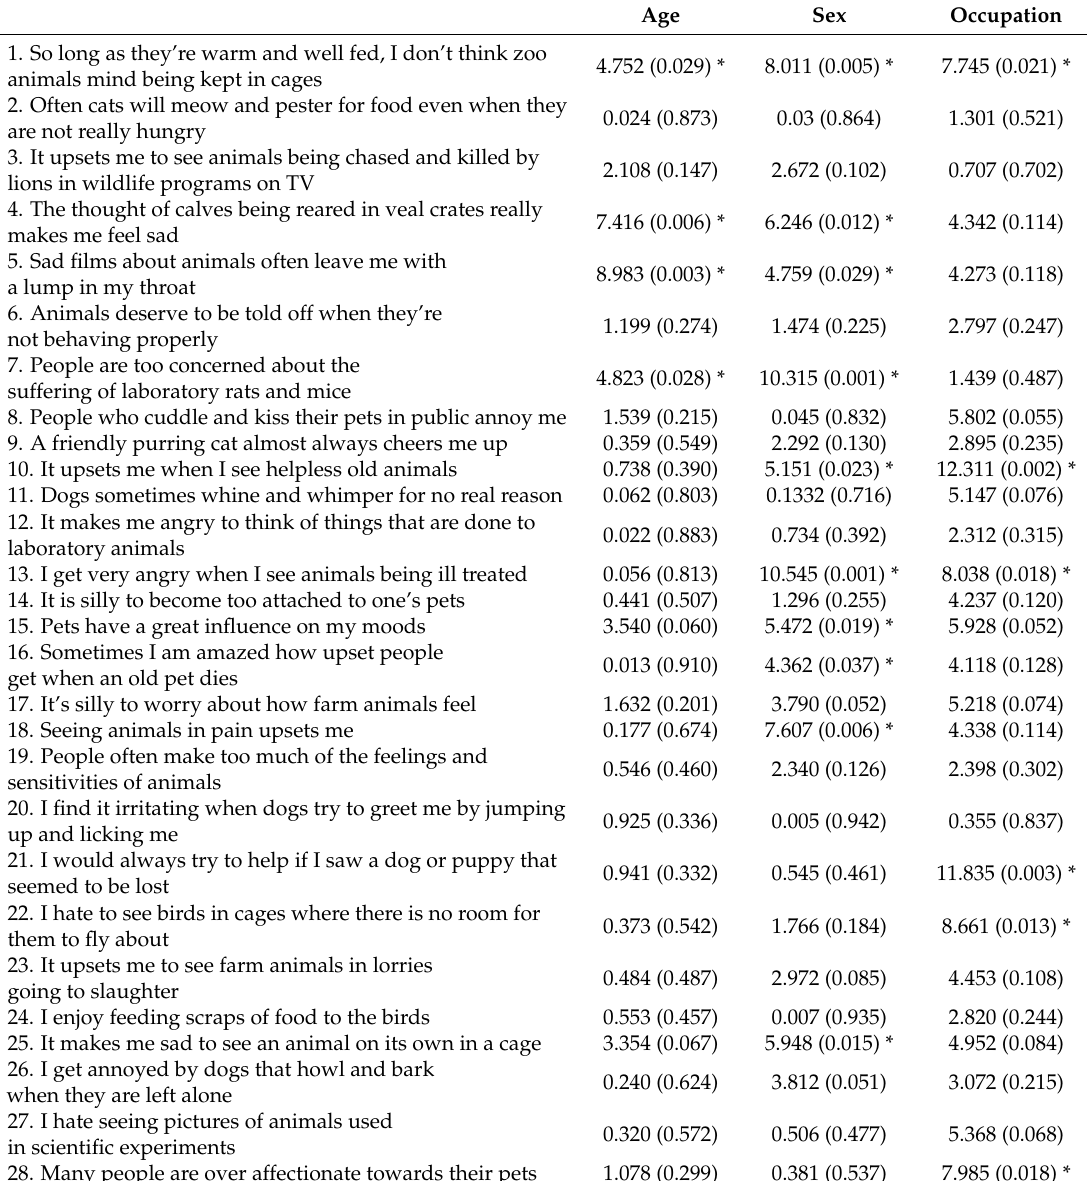
Table 3. The Logistic Regression Chi-Square test χ 2 ( p -values) for participants’ ( n = 41) demographics and their responses to statements regarding emotional empathy with